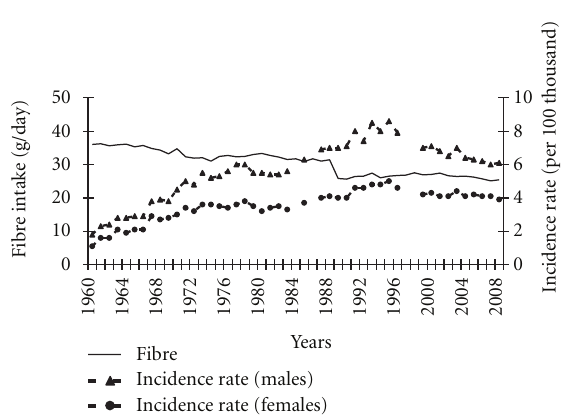
Figure 10: Fibre intake and pancreatic cancer morbidity 1960– 2008.